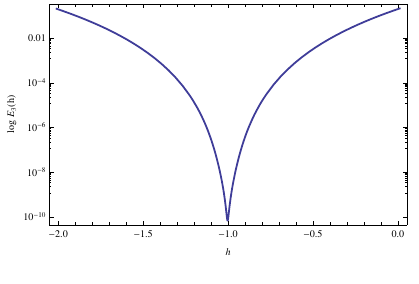
Figure 1. Logarithm of squared residual E 3 ( h